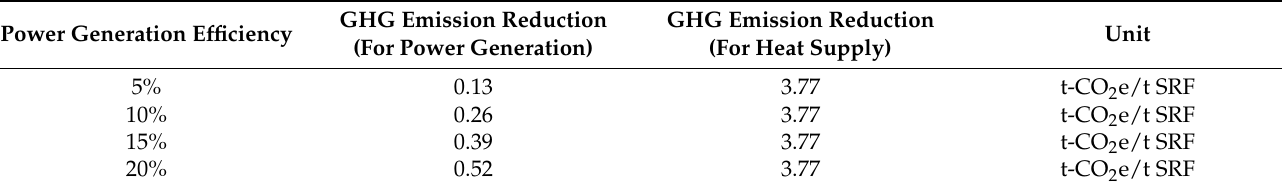
Table 14. SRF using for power generation and heat